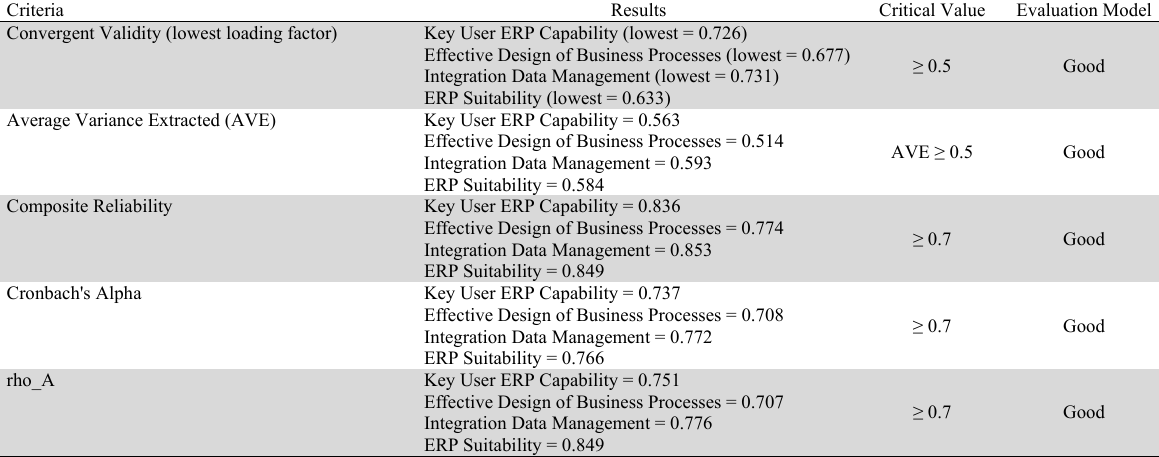
Table 1 Evaluation Criteria for Conformity of Outer Model